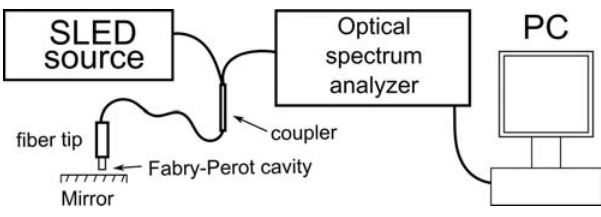
Fig. 2. Low-coherence interferometer laboratory